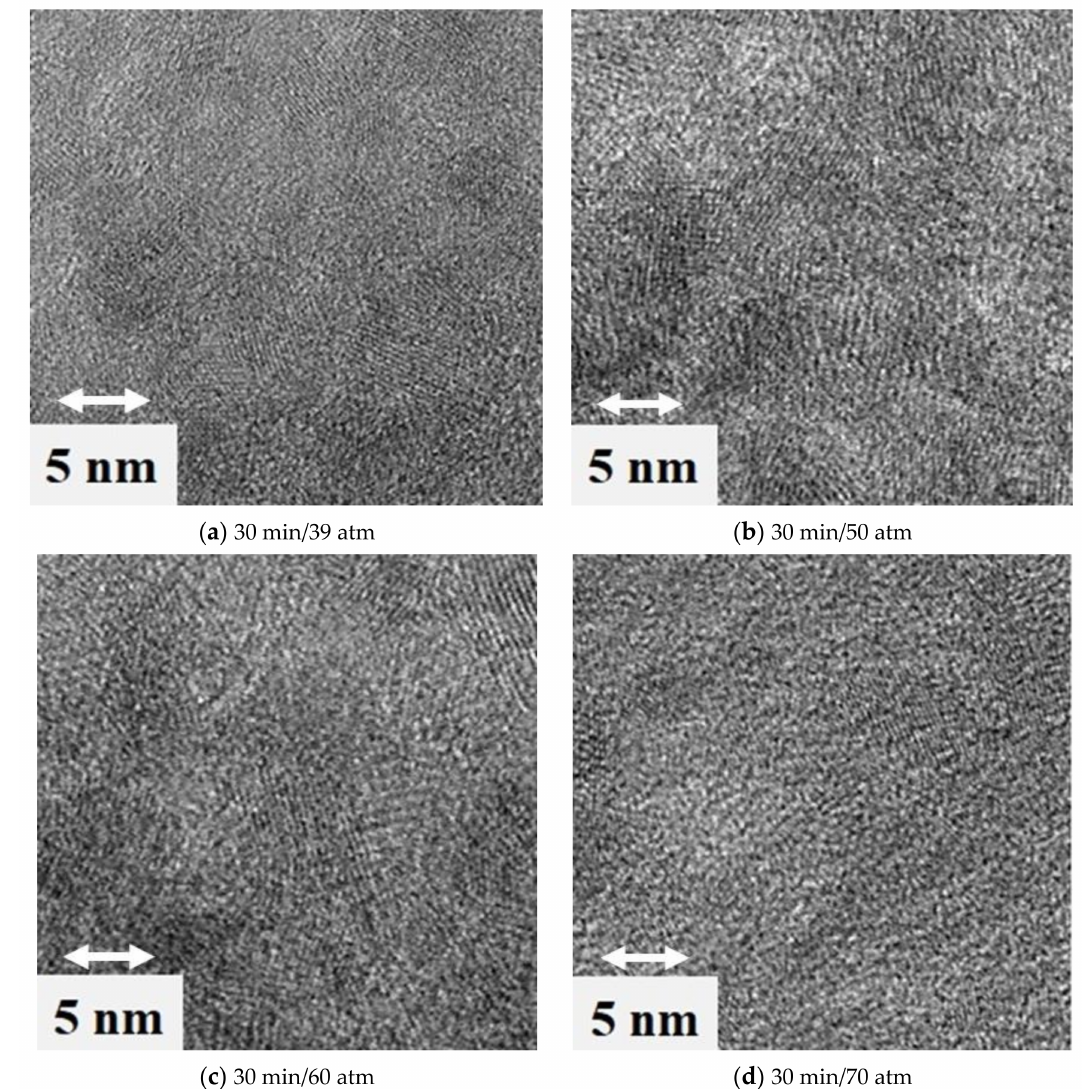
Figure 6. TEM pictures of samples obtained at the optimum process time of 30